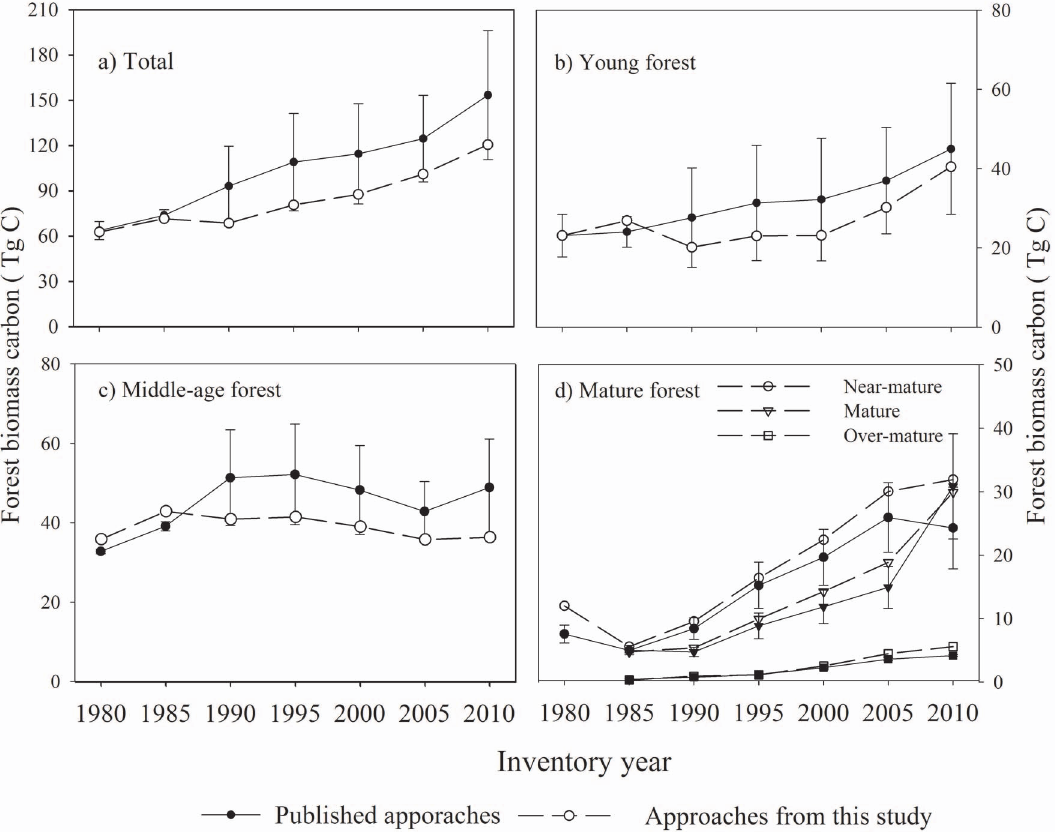
Figure 5. Estimates of forest biomass carbon by CBM (continuous biomass expansion factor method) by forest groups with age class from that in published studies and in this study.